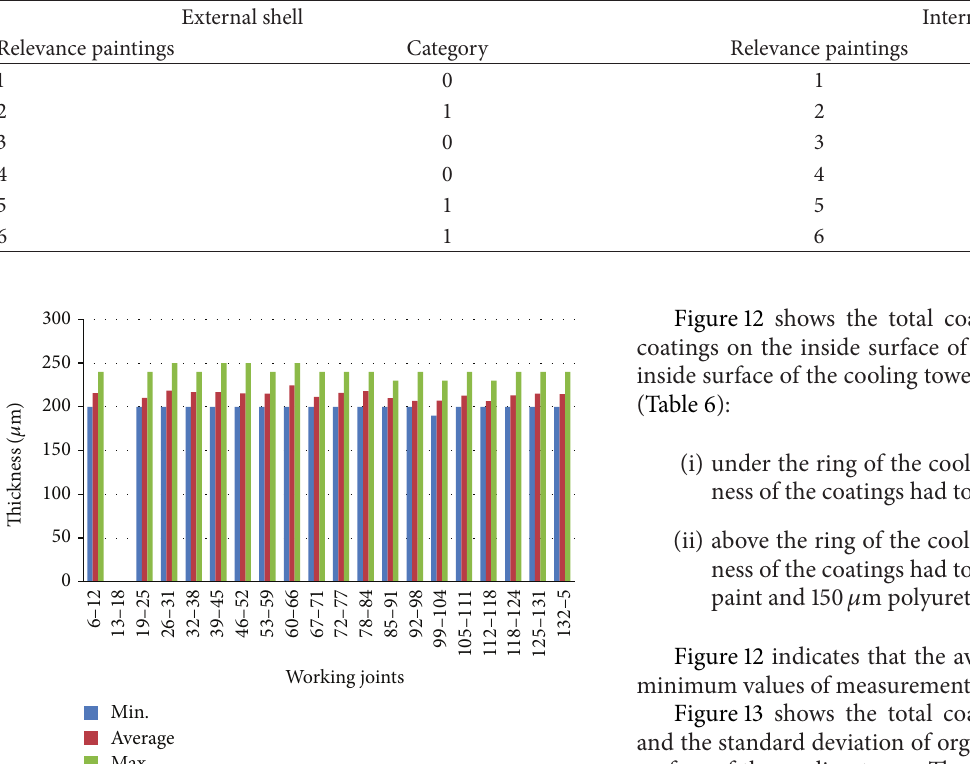
Figure 12 indicates that the average is 400 𝜇 m. Even the minimum values of measurements are over 350 𝜇 m. Figure 13 shows the total coating standard deviation% and the standard deviation of organic coatings on the inside surface of the cooling tower. The average of standard devia- tion% was 10.59. Analytical measurements of Figures 12 and 13 are presented in Table